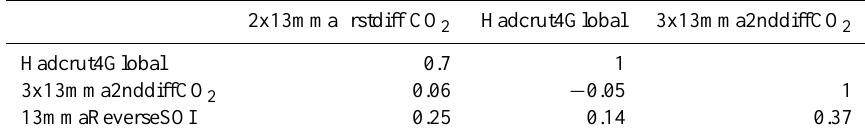
Table 5. Pairwise correlations (correlation coefficients ( R )) between selected climate